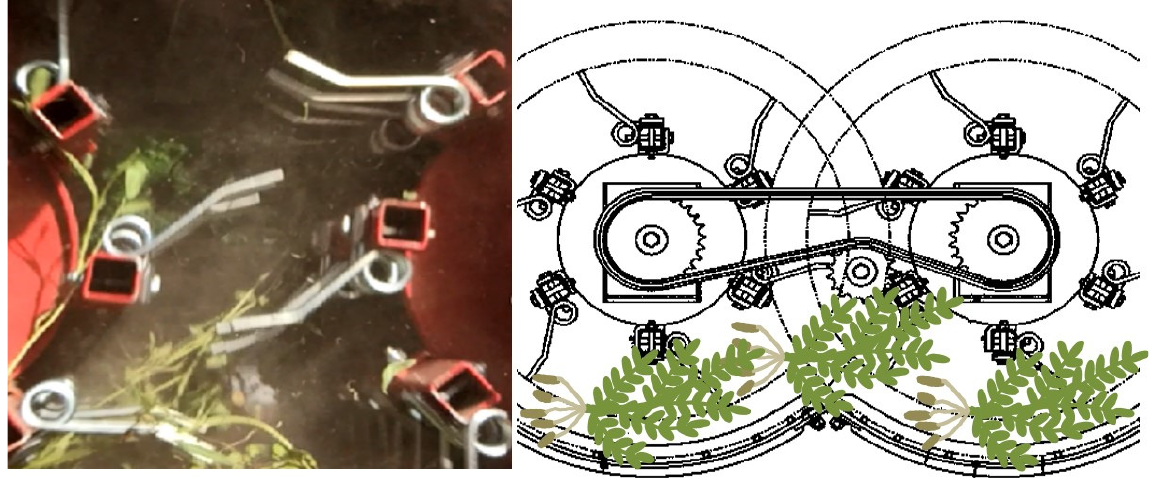
Figure 1. Schematic diagram of the peanut pod picking process .